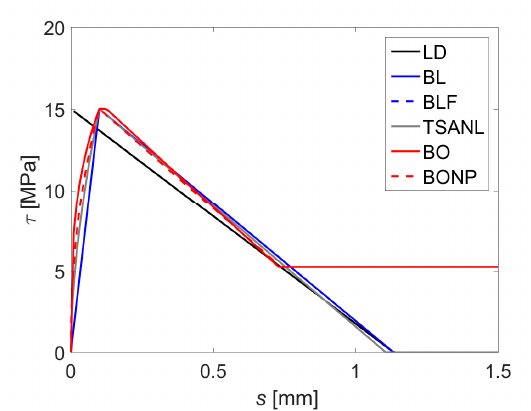
Figure 6. Comparison of the bond–slip models. Materials 2020 , 13 , x FOR PEER REVIEW